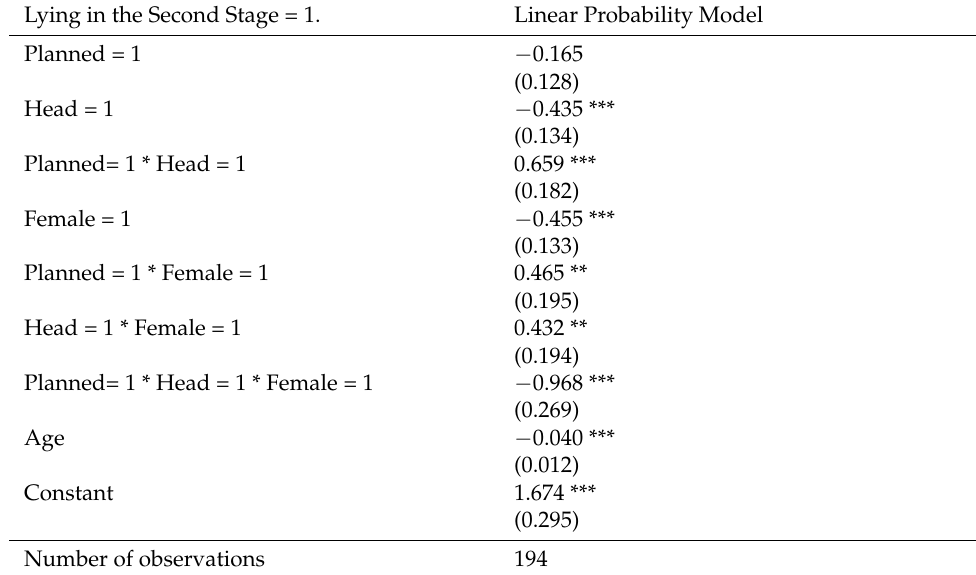
Table A1. Robustness checks for second stage lying behavior. Lying in the Second Stage =